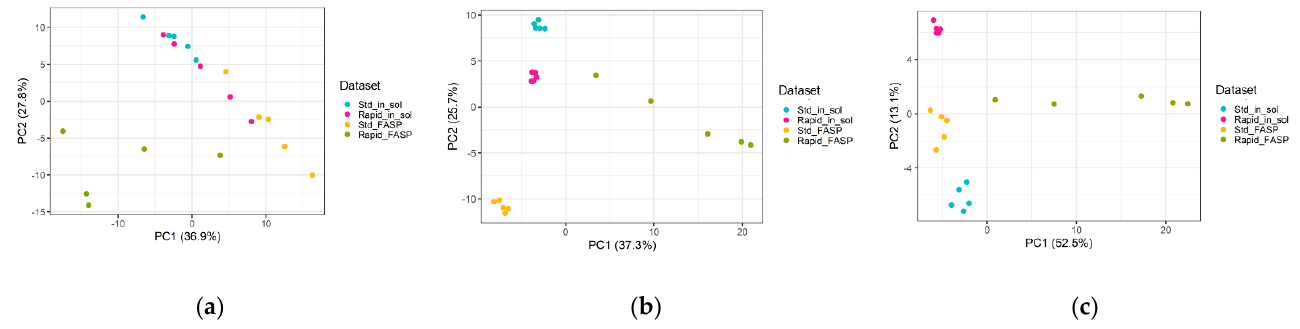
Figure 10. Evaluation of data normalization effectiveness. Principal component analysis (PCA) of the protein levels in different sample: ( a ) based on raw intensities; ( b ) based on LOESS normalized intensities; ( c ) based on MaxQuant’s normalized LFQ intensities. The PCA based on protein intensities showed the rapid FASP as the least reproducible. Additionally, both normalization strategies were not effective in improvement of replicate clustering (minimize the data redundancy).